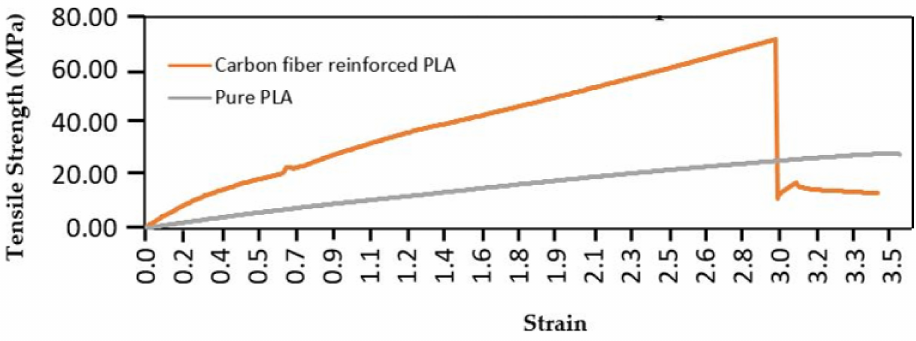
Figure 6. Pure PLA vs. carbon fiber reinforced specimen.